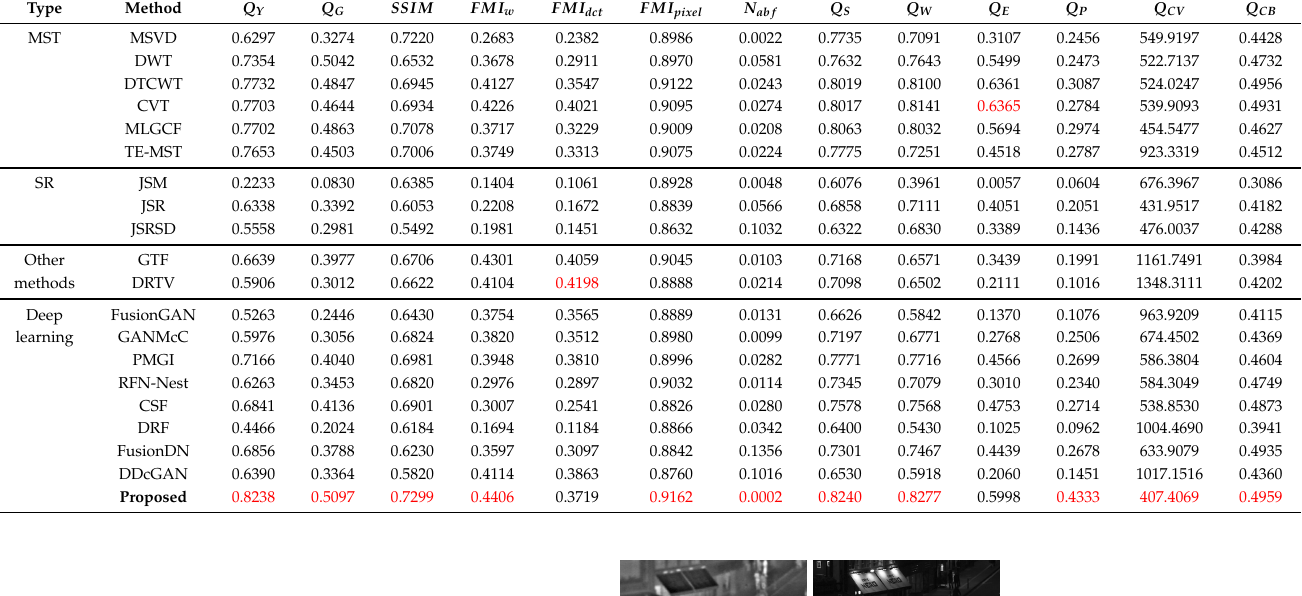
Table 4. The average values of different methods on the TNO dataset.